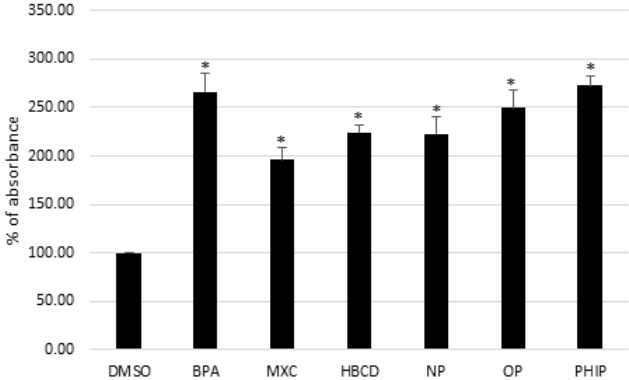
Figure 3. Collagen invasion assay of mammary epithelial cell (HME1) cell line exposed to various chemicals as compared to the base line invasion of control (vehicle-exposed) HME1 cell line. Cells were treated with nanomolar concentrations (BPA, MXC, HBCD, NP, OP, and PhIP at 0.0043, 0.0028, 0.0015, 0.0045, 0.0048, and 0.0044 nM, respectively) for two months then cells were serum starved and tested for their ability to invade through college-coated membrane using Boyden chambers. Invaded cells were fixed, stained, and visualized under the microscope and then the dye was eluted and measured using a plate reader. ( A ) Representative figures to show the differences in invasion potential as detected by microscopic examination. ( B ) quantitative evaluation of cell invasion as measured by dye elution and spectrophotometric reading at 560 nm. Mean ± SEM, * p < 0.05, n = 3.